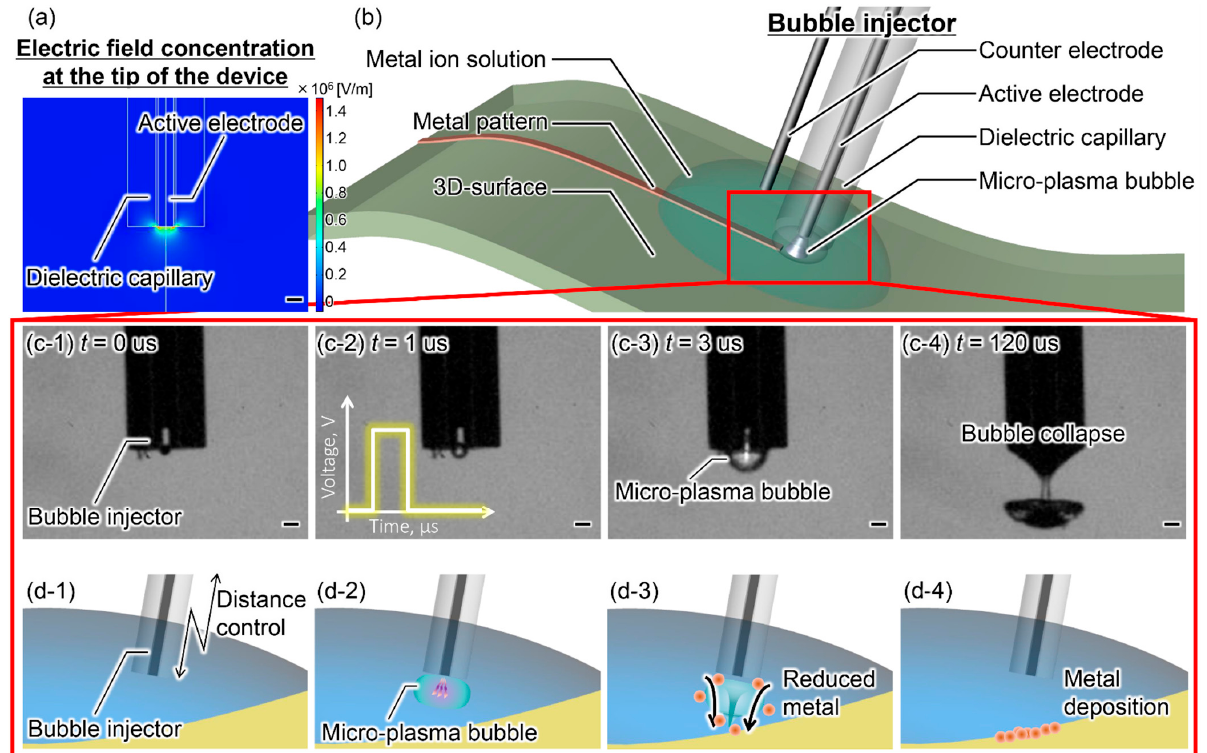
Figure 1. Overview of the metal deposition method using micro-plasma bubbles. All scale bars are 100 µm. ( a ) Finite element analysis of the electric field at the tip of the bubble injector. The active electrode is tungsten, the dielectric capillary is glass, and the voltage is 700 V. ( b ) Components of the proposed method and the concept of metal patterning. ( c ) Sequence of micro-plasma bubbles. The solution is a 0.9% sodium chloride solution, the voltage is 1000 V, and the pulse width is 10 µs. ( d ) Concept of the metal deposition process using micro-plasma bubbles.